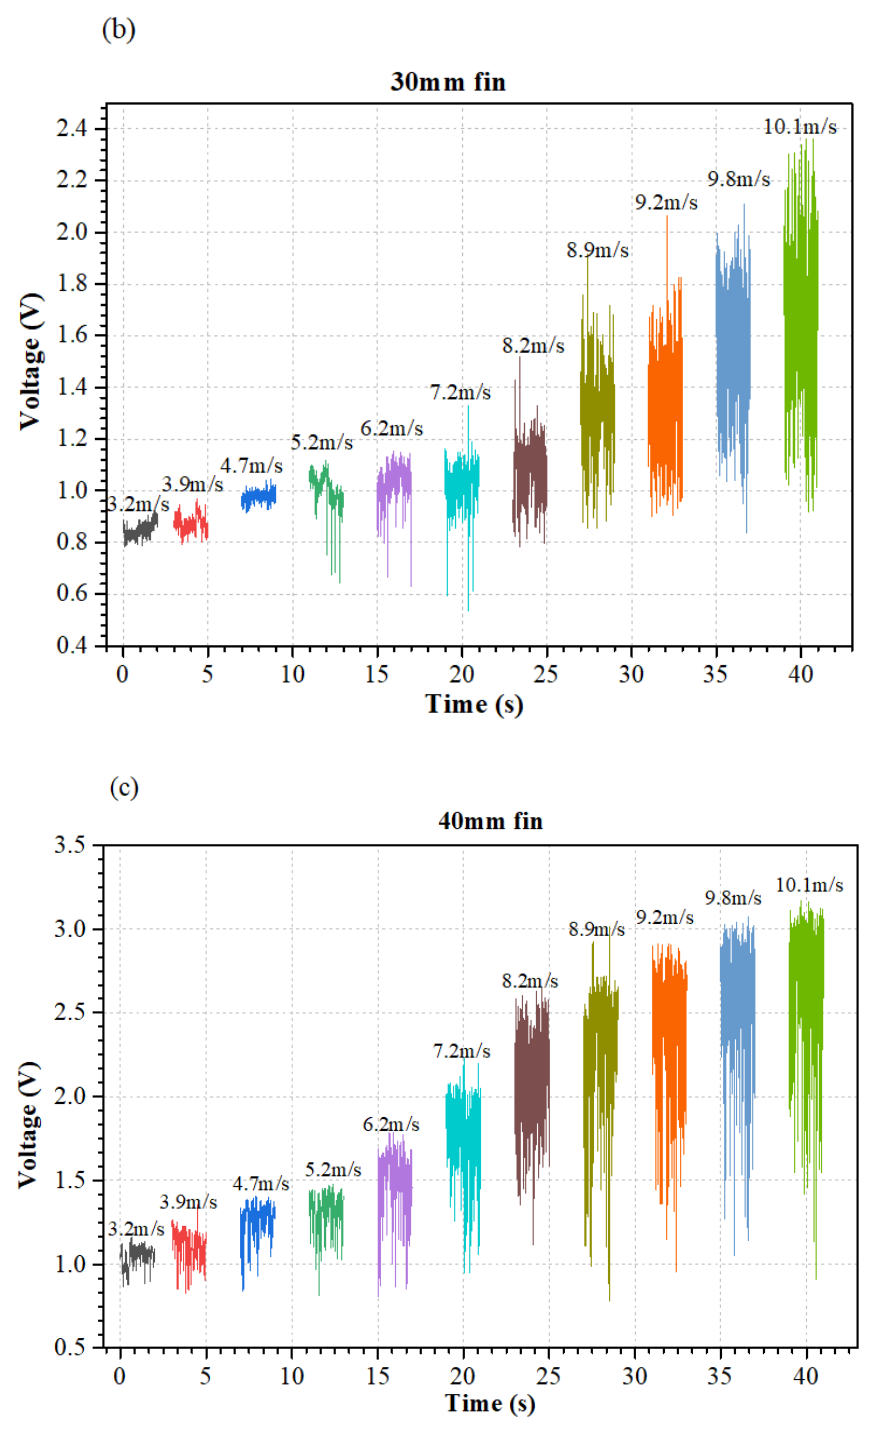
Figure 6. Raw voltage signals of the airflow sensors with fin sizes of ( a ) 20 mm; ( b ) 30 mm; ( c ) 40